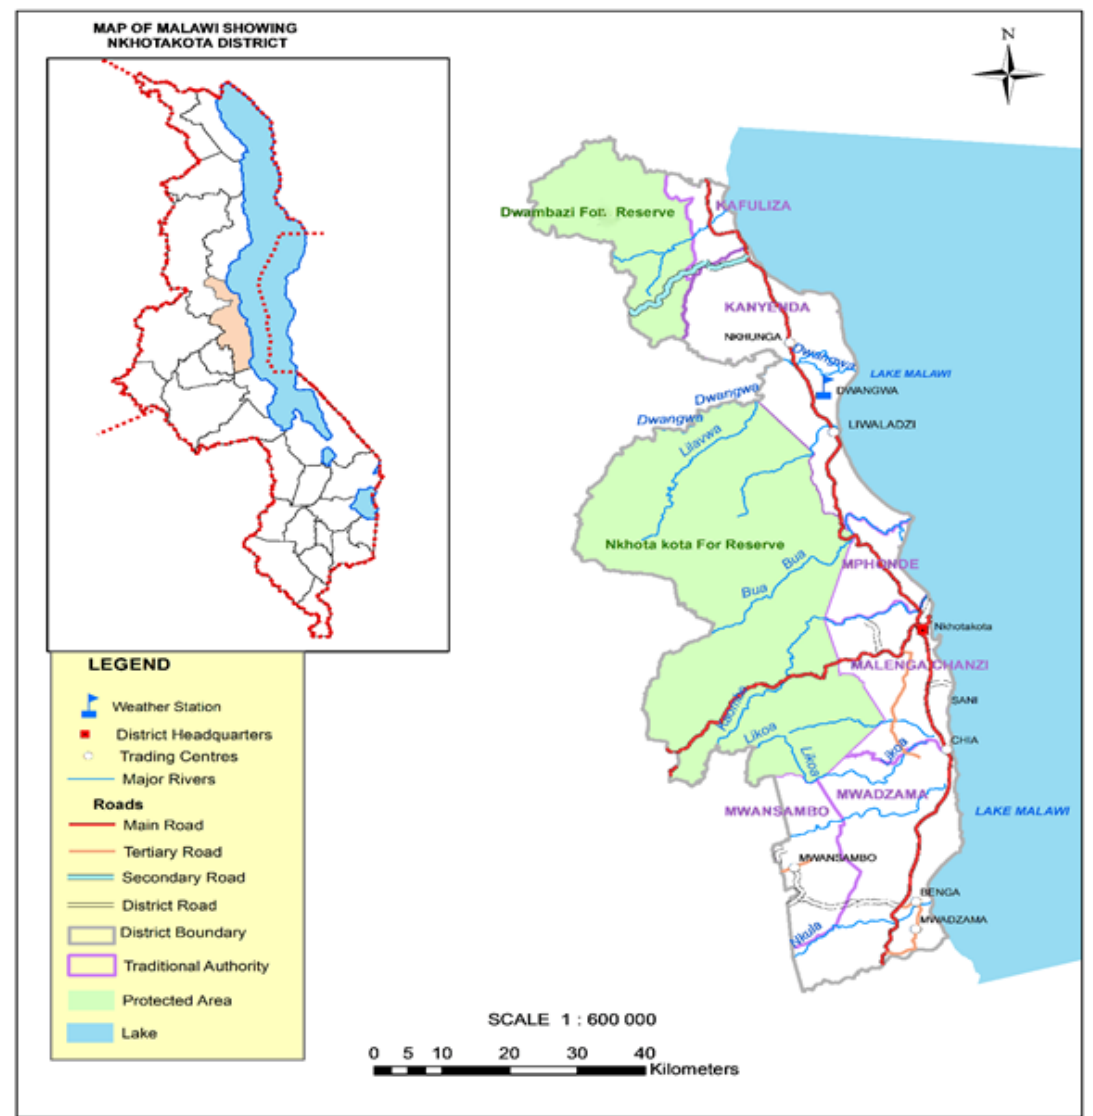
Figure 2. Map of Malawi showing Nkhotakota district and the study area.